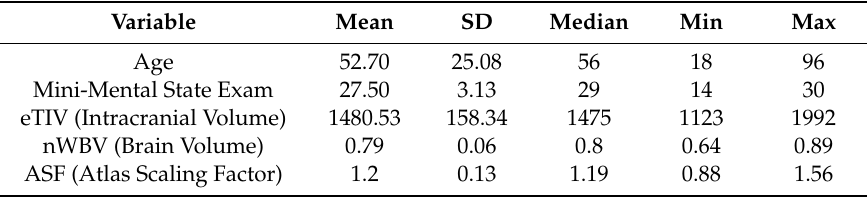
Table 3. Descriptive statistics for the quantitative variables ( n =